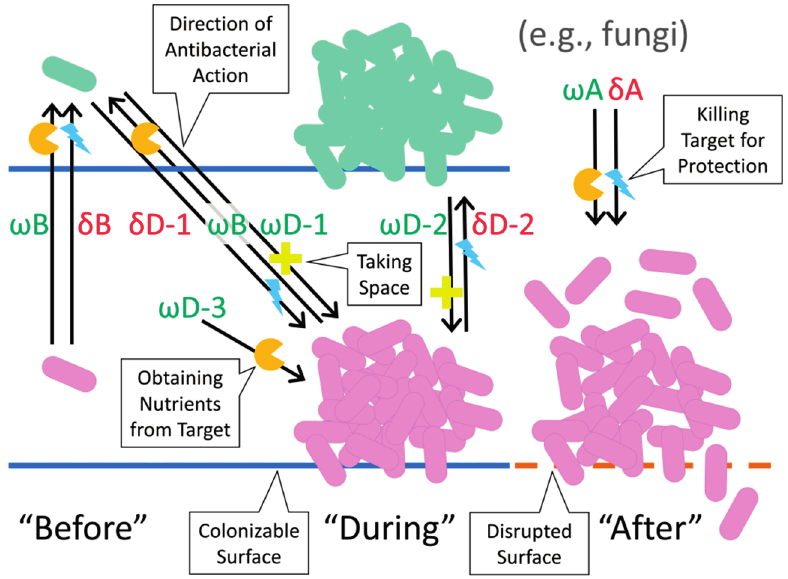
Figure 1. Diagrammatic representation of material presented in Table 1. Arrows point in the direction of antibacterial action, from antibacterial producer to antibacterial target. As abbreviated: “ ω ” refers to “Offense”, “ δ ” to “Defense”, “B” to “Before”, “D” to “During”, and “A” to “After”. Orange “Pacman”-like symbols refer to antibacterial deployment that is followed by consumption of target organisms for nutrients, turquoise lightning bolts refer to antibacterial-mediated killing of target organisms for the sake of protection of producing organisms, and yellow crosses refer to antibacterial action against target organisms for the sake of obtaining colonizable surfaces ( i.e. , “Space”) by producer organisms. The solid, blue horizontal lines refer to intact colonizable surfaces while the brown dashed line refers to an equivalent but disrupted surface. The arrow labeled with ω D-3 (see also Table 1) refers to as effected by either disseminating or instead biofilm-associated bacteria. A second δ B arrow, equivalent in placement to the second-from-the-left ω B arrow, has been omitted from the figure to reduce clutter. The actions indicated in the right-hand third of the figure are as potentially effected by